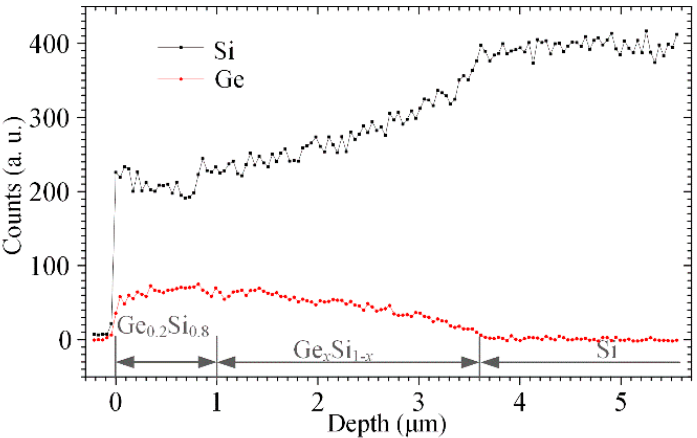
Figure 3. Elemental distribution along the depth direction achieved by using energy-dispersive spectroscopy (EDS).